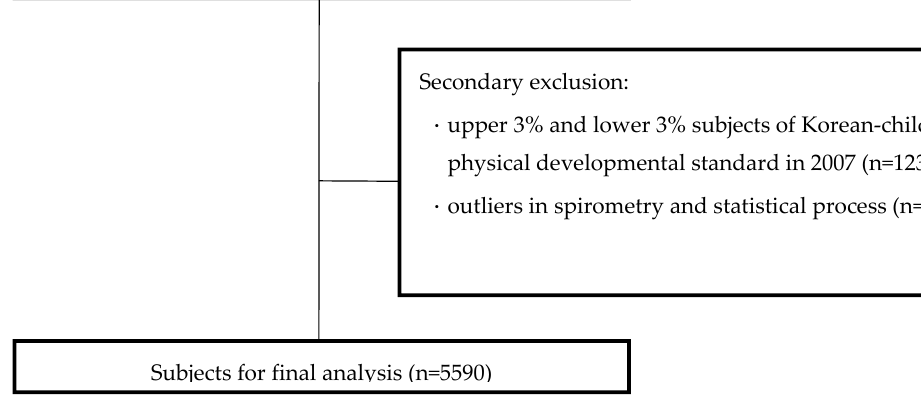
Figure 1. Study profile.